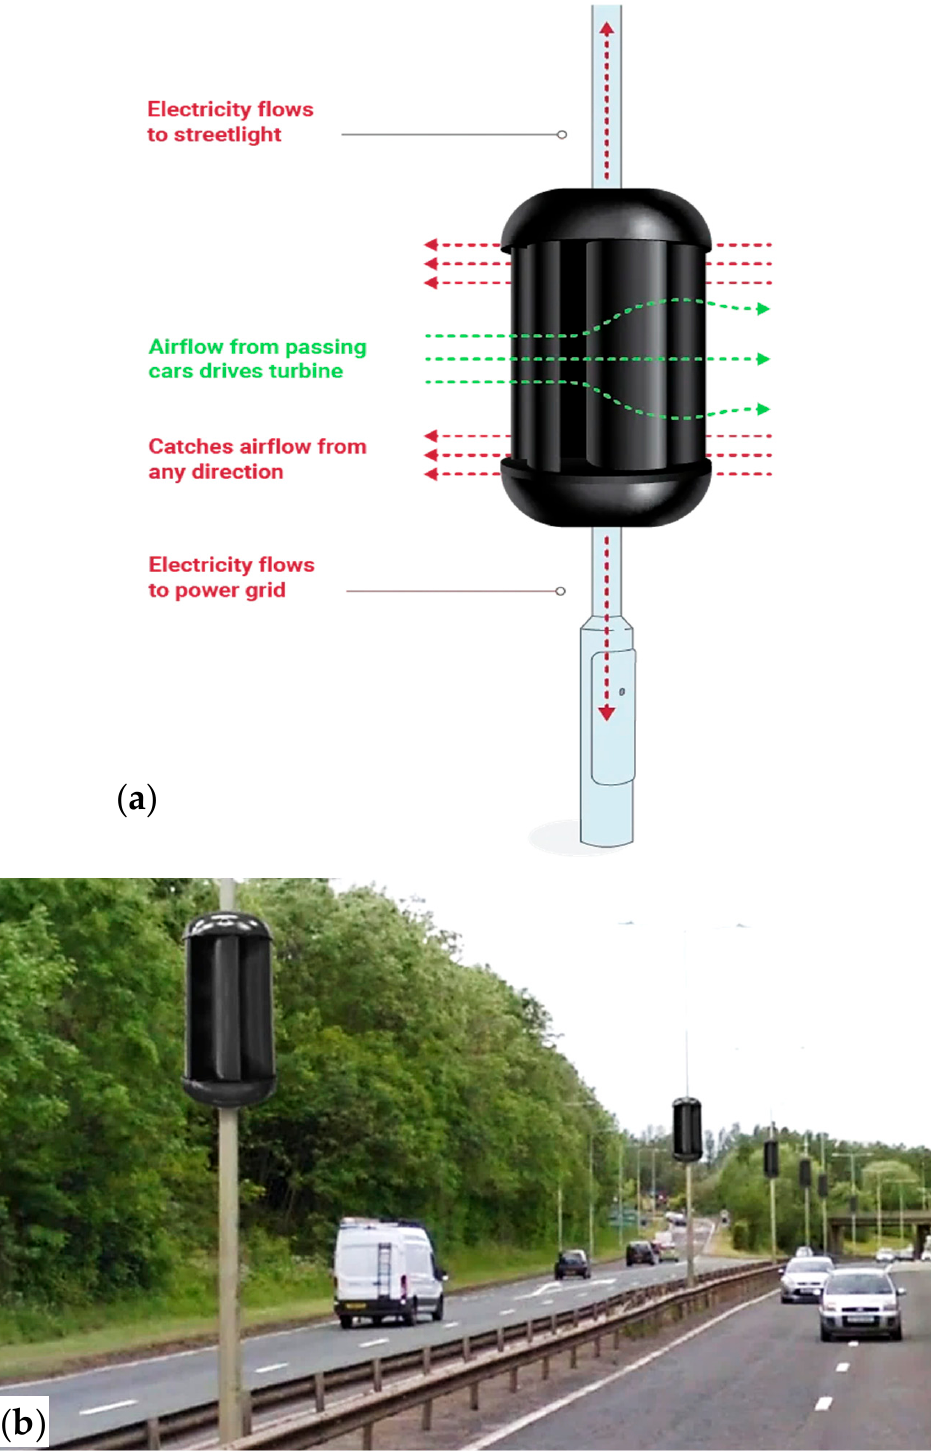
Figure 21. ( a ) Operation scheme of the Alpha 311 turbine, ( b ) application of Alpha 311 turbines in the road’s median, properly designed to be retrofitted to existing infrastructure such as streetlights alongside roads. (Reprinted with permission from Ref. [129]. Alpha 311 Ltd., Kent, UK) [129].